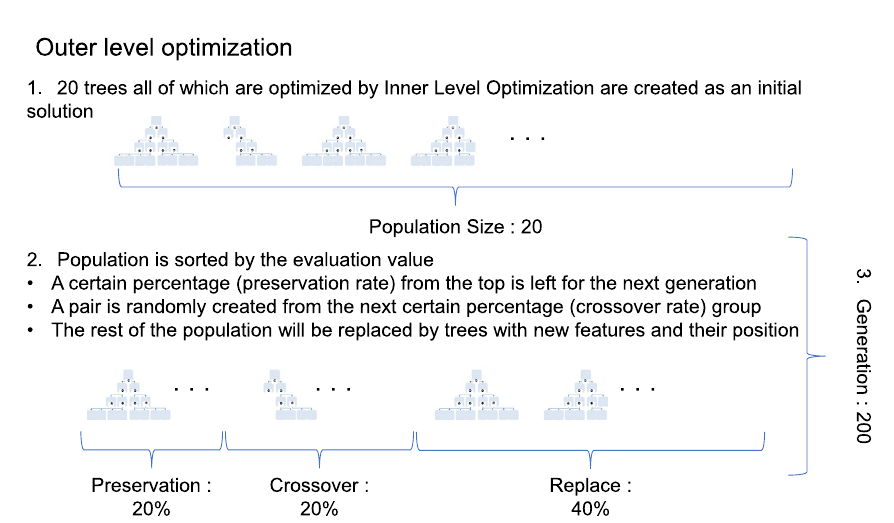
Fig. 2 Outline of bilevel genetic algorithm (GA) used in this